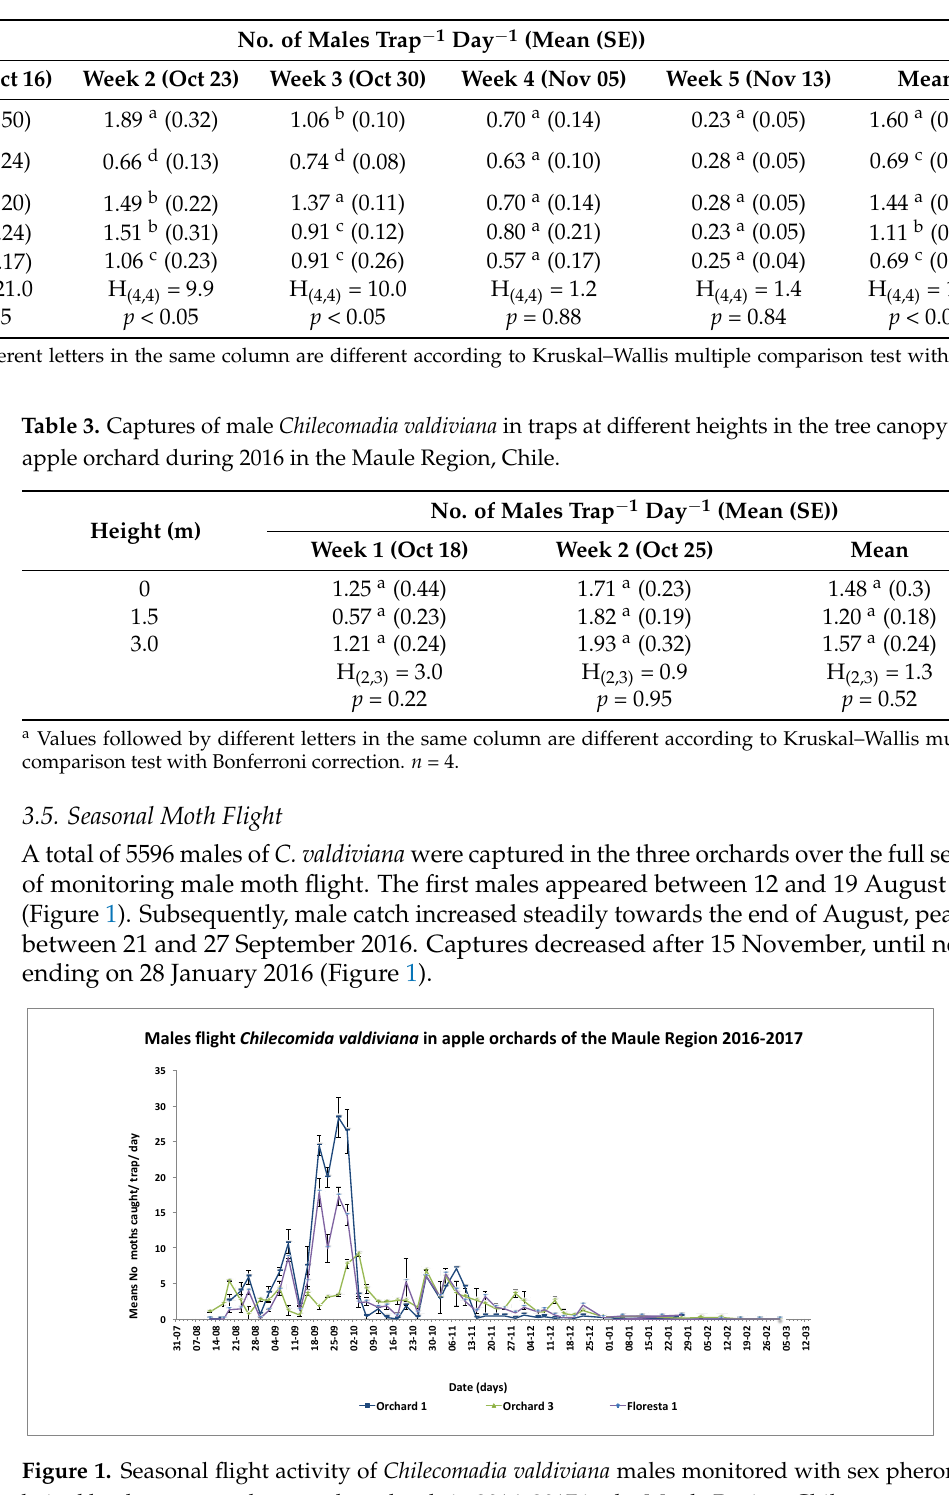
Table 2. Captures of male Chilecomadia valdiviana in different types of traps in an apple orchard during 2016 in the Maule Region, Chile.